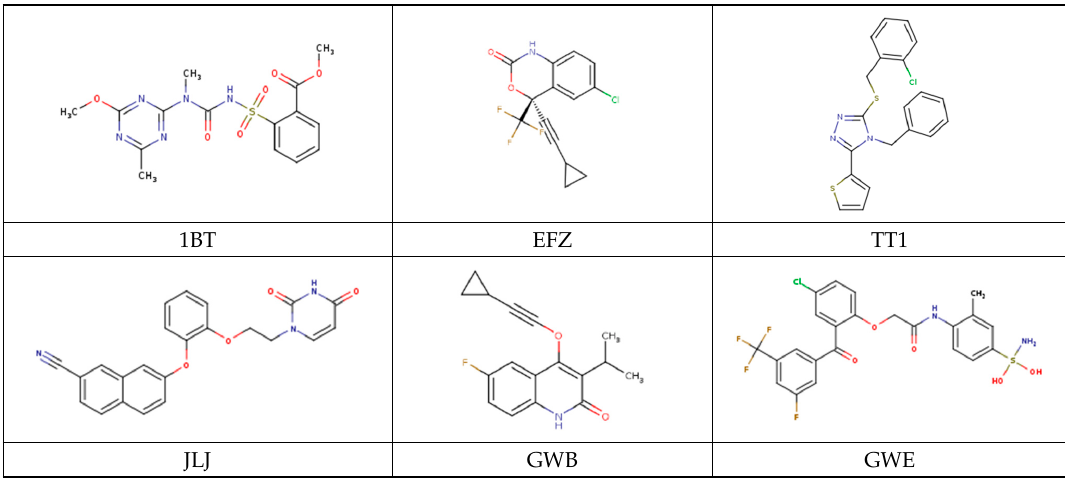
Table 5. Structures of ligands used in studies.